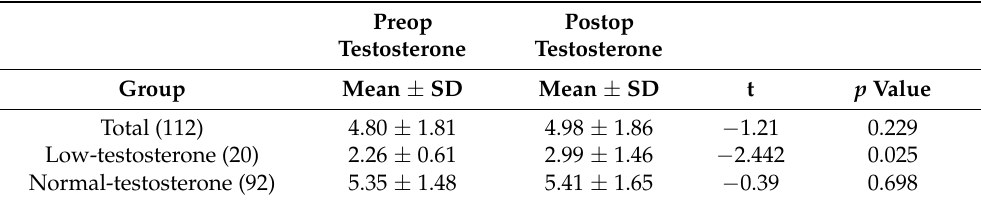
Table 3. Comparison between preoperative and postoperative testosterone levels in the low- and normal-testosterone groups.